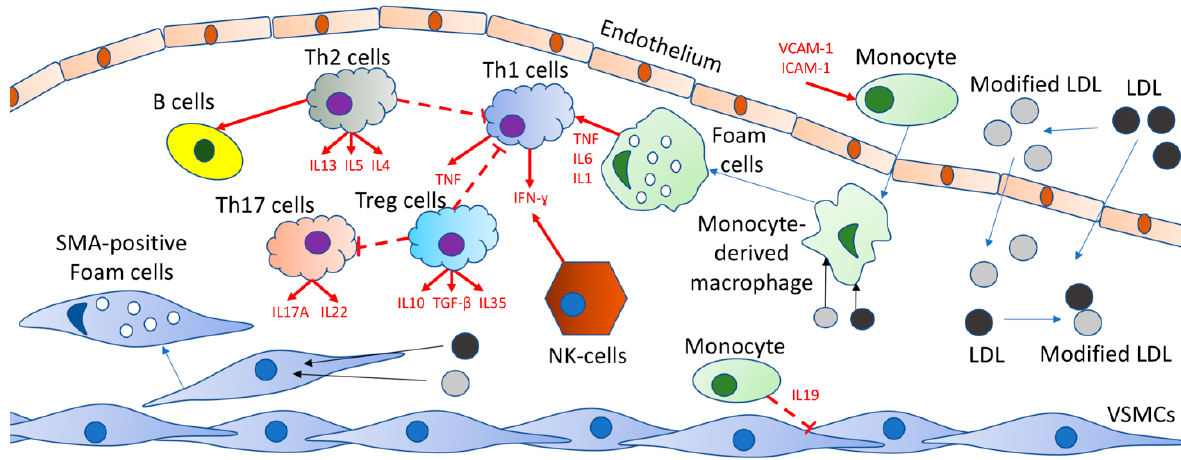
Figure 1. The number of immune cells within the arterial wall is increased at the site of plaque formation. LDL particles undergo multiple modifications and accumulate in the vascular wall where they are internalized by monocyte-derived macrophages and VSMCs, which transform into foam cells. This triggers the productions of cytokines (TNF, IL1, IL6) by foam cells. These cytokines induce the influx and activation of other inflammatory cells and mediate their retention in the plaque, leading to further accumulation of inflammatory cells in the plaque and surrounding adventitia. In particular, these cytokines activate Th1 cells, which produce TNF and IFN- γ , which are also generated by NK cells. Th2 cells also release various cytokines, among which IL3, IL5, and IL4. IL4 mediates the activation of B cells. Th17 cells release IL17A and IL22, while Treg cells generate TGF- β , IL10, and IL35 and block Th17 and Th1 cells.